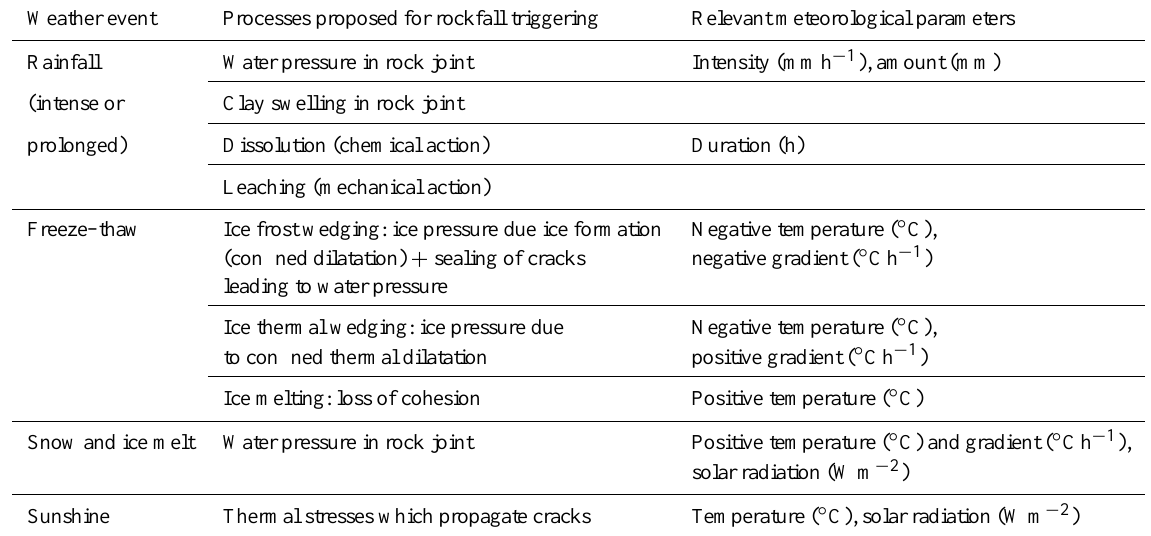
Table 1. Meteorological factors and triggering